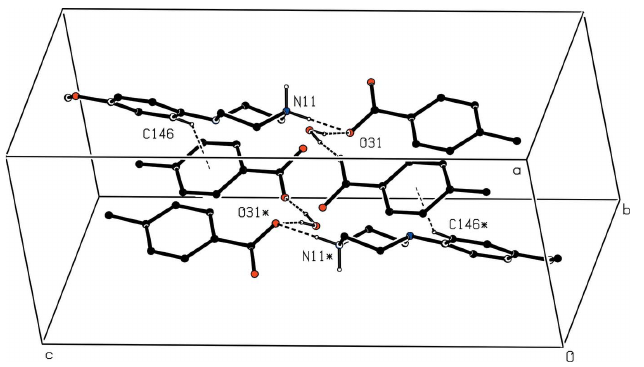
Figure 7 Part of the crystal structure of compound (I) showing the formation of a ring containing O—H (cid:2)(cid:2)(cid:2) O, N—H (cid:2)(cid:2)(cid:2) O and C—H (cid:2)(cid:2)(cid:2) (cid:2) (arene) hydrogen bonds that link adjacent [010] chains. Hydrogen bonds are drawn as dashed lines and, for the sake of clarity, the H atoms bonded to those C atoms that are not involved in the motif shown have been omitted. The atoms marked with an asterisk (*) are at the symmetry position (1 (cid:3) x , 1 (cid:3) y , 1 (cid:3) z ).